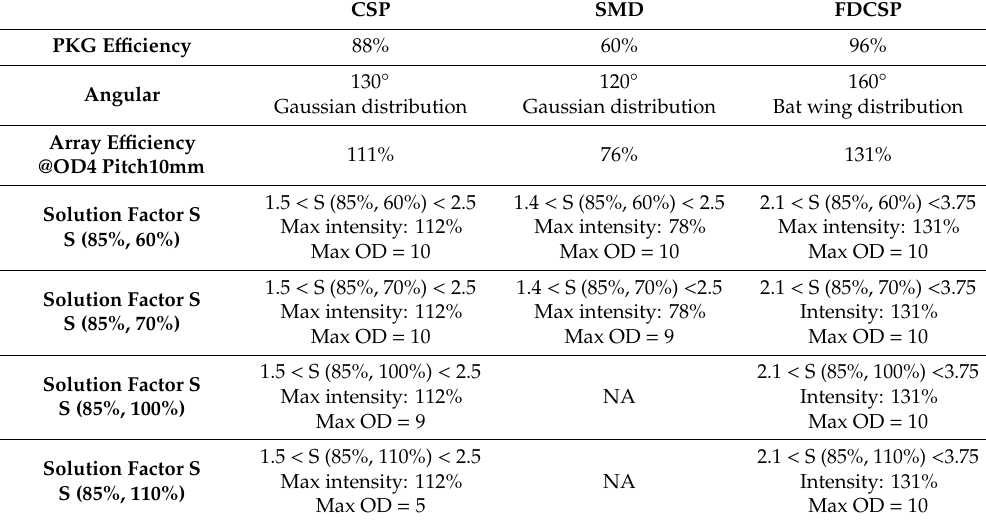
Table 2. Comparison of di ff erent light